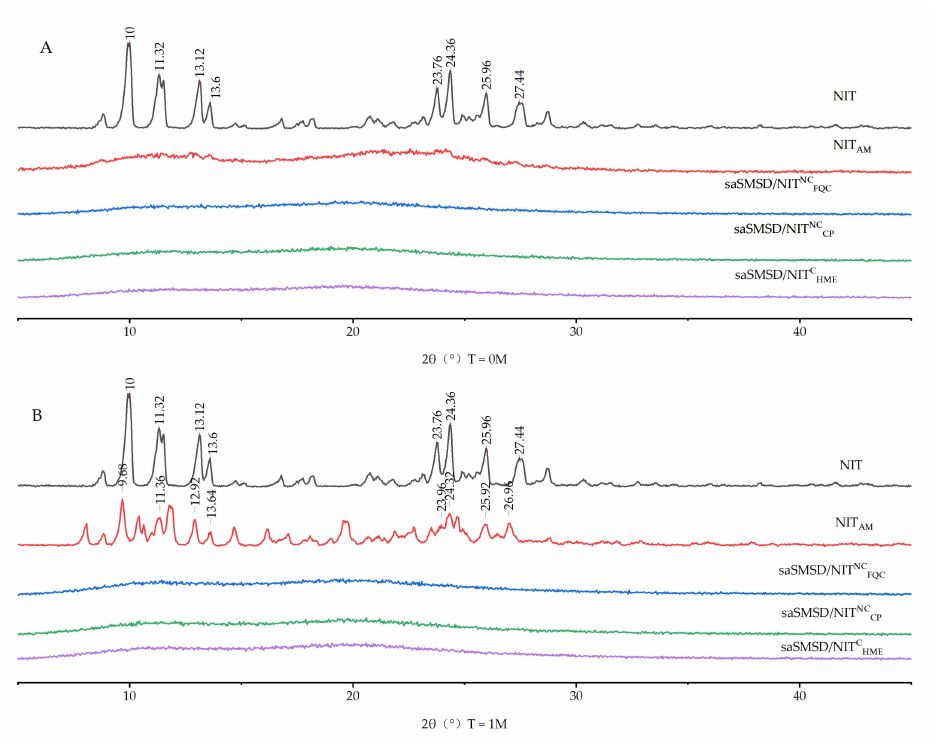
Figure 10. Stability Powder X-ray diffractogram of NIT, NIT AM , saSMSD/ NIT NC FQC , saSMSD/ NIT NC CP , saSMSD/ NIT C HME at 0 month ( A ), 1 month ( B